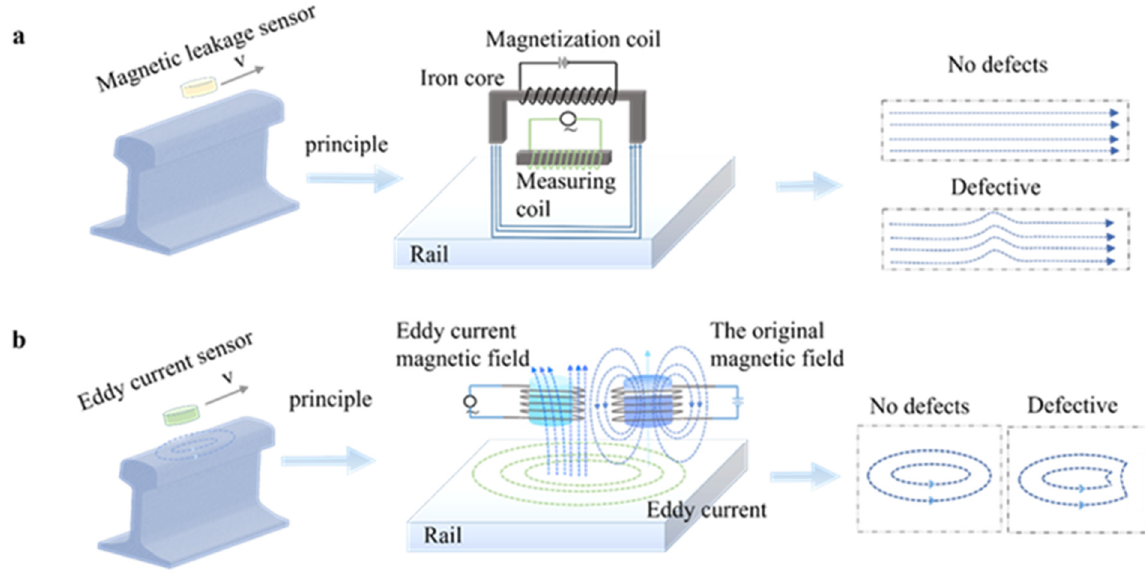
Figure 4. ( a ) Eddy-current detection. ( b ) Magnetic flux leakage detection.